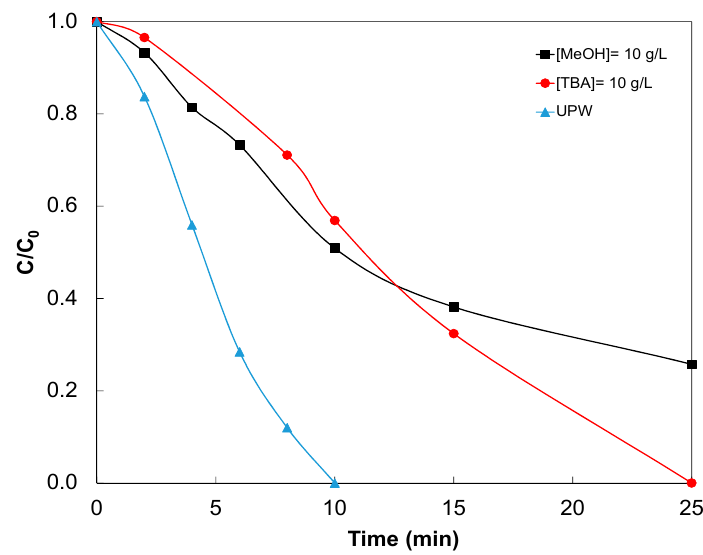
Figure 8. Effect of radical scavengers on SMX degradation. Experimental conditions: C SMX = 500 μ g/L; C LNO = 250 mg/L; C SPS = 100 mg/L; pH = 6; room temperature.